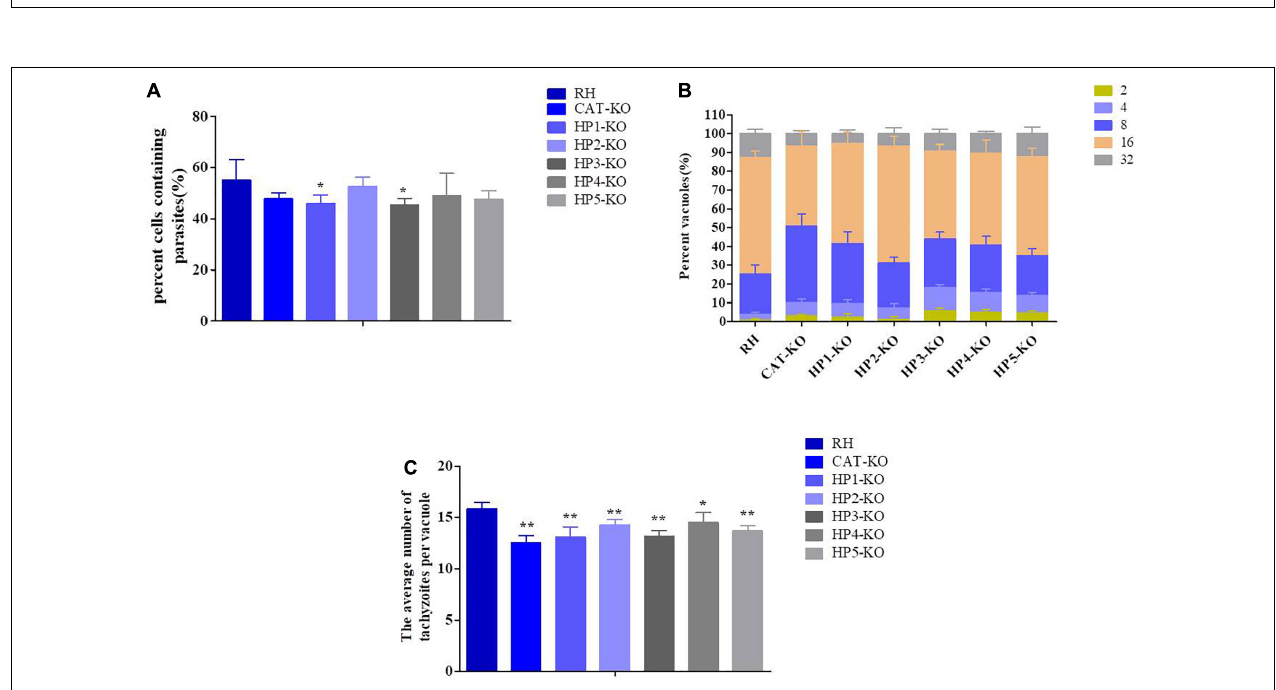
FIGURE 5 | Invasiveness and proliferative potential of hypothetic protein ( HP )-knockout (KO) Toxoplasma gondii strains. (A) Invasiveness potential of HP -KO strains. (B,C) Parasite replication was assessed by calculating the number of tachyzoites in each vacuole after 36 h of infection for a minimum of 100 vacuoles per strain. Data are represented as the mean ± standard deviation ( n = 4). ** P < 0.01, * P < 0.05, significant changes versus controls.